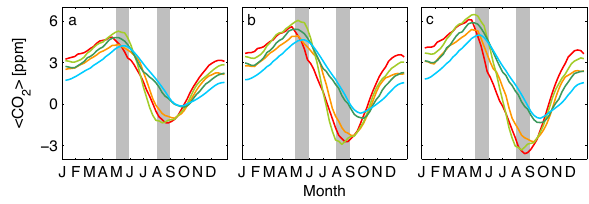
Fig. 14. Detrended h CO 2 i at TCCON sites in three simulations with different surface fluxes. (a) CASA fluxes. (b) Boreal fluxes en- hanced. (c) Boreal fluxes enhanced with early onset of the growing season. When boreal fluxes are increased, the seasonal cycle am- plitude increases. When the length of the growing season increases, the seasonal cycle amplitudes increase further despite no increase in net exchange between (b) and (c) . Colors are the same as Figs. 8–9. Daily data from the shaded periods (May and August) are plotted in Fig. 15.